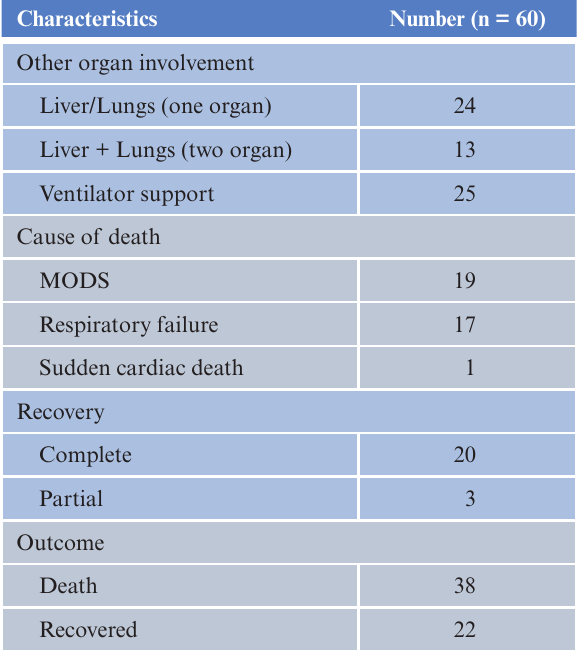
Table 2: Statistical results for